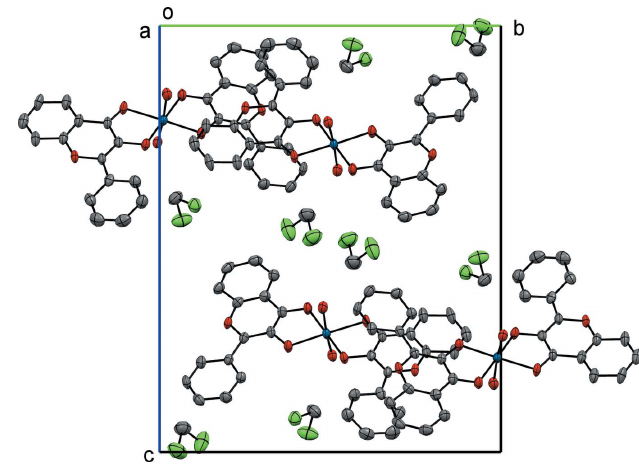
Figure 1 A view of the molecular components in the structure of the title compound, showing the atom labeling. Displacement ellipsoids are drawn at the 50% probability